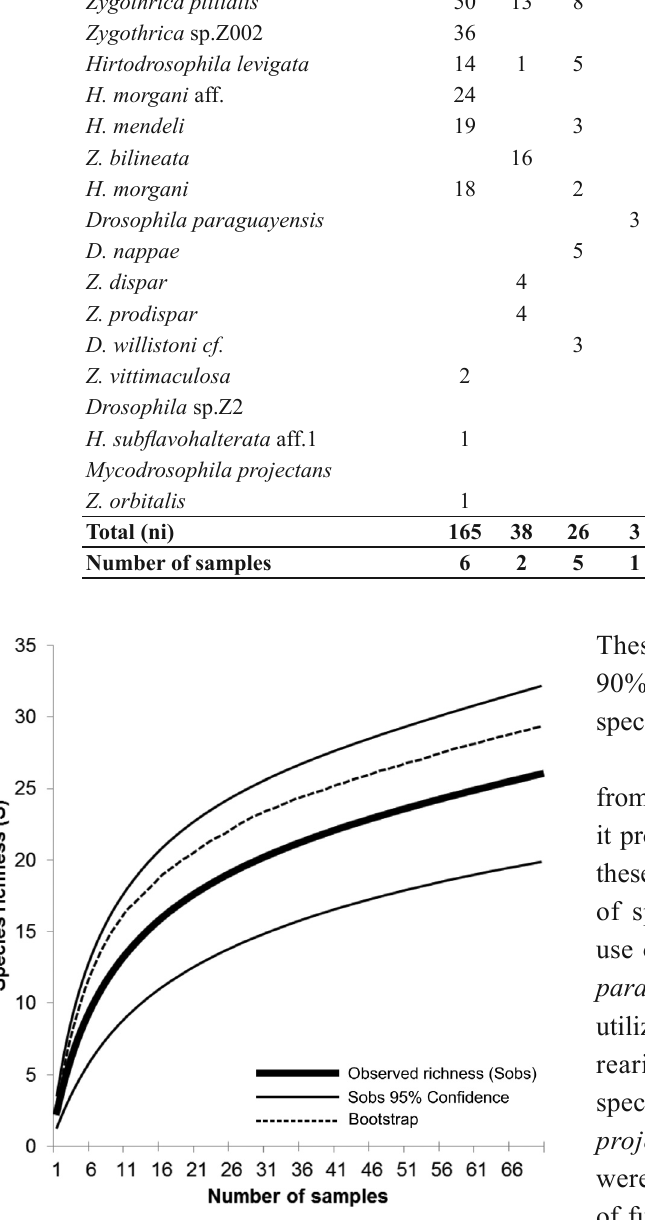
Figure 2 - Species accumulation curve for the drosophilid assemblage and species richness estimation by the bootstrap